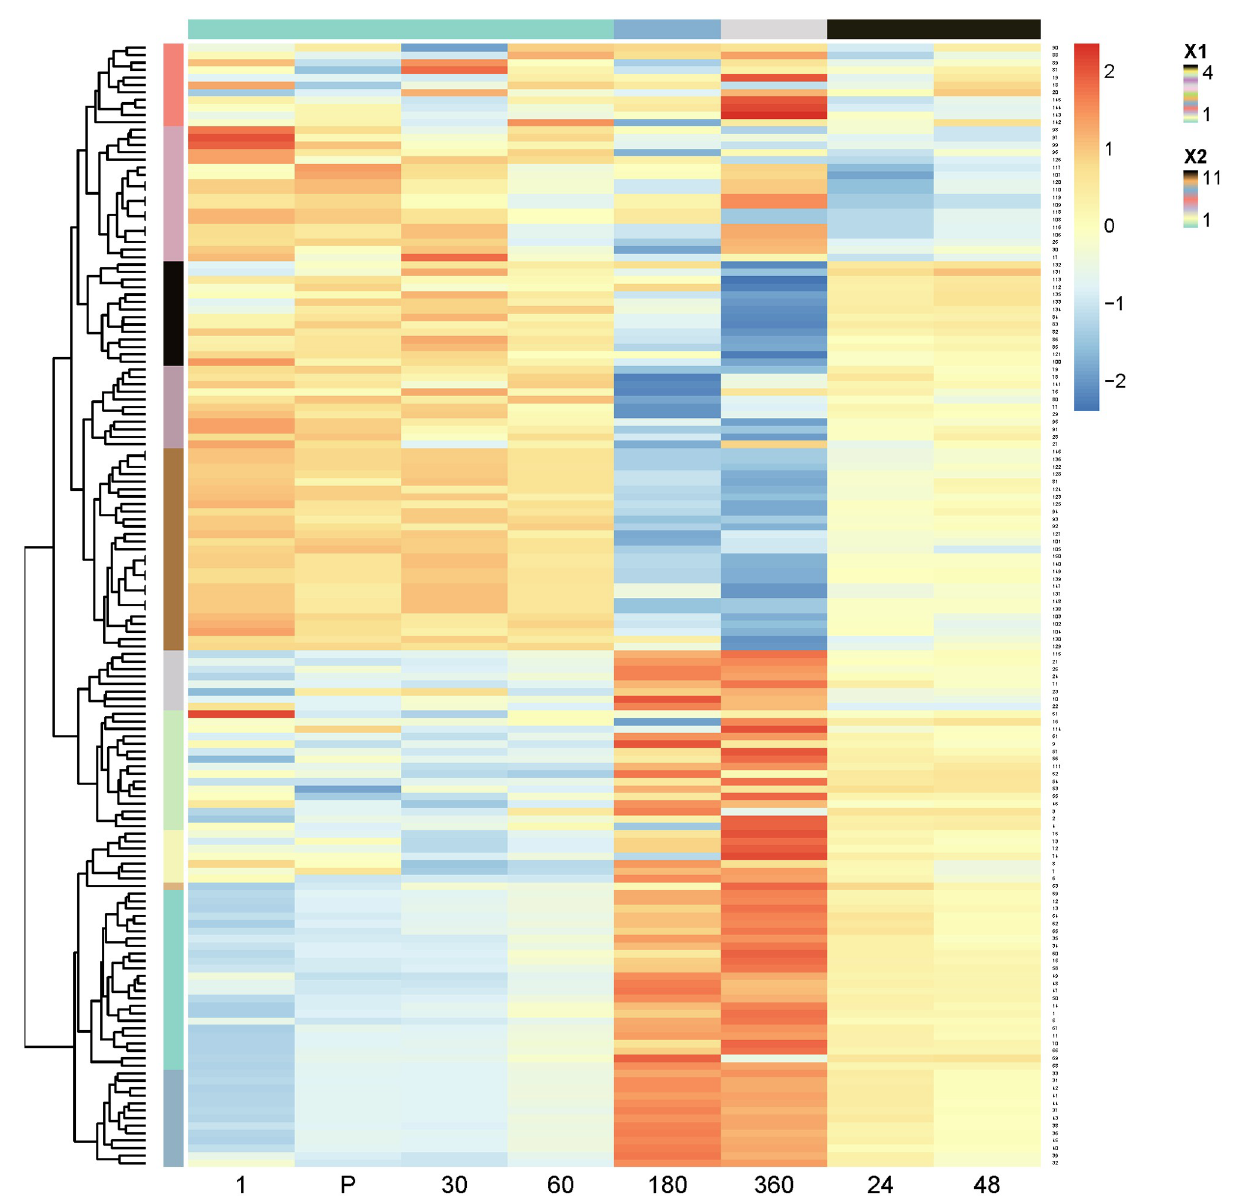
Fig 5. Scores for all 150 sample points ( y axis) and 8 time points ( x axis) for PC3. The colour of each cell represents the score value. Clusters of sample points are shown with coloured regions and a tree on the left hand side, and clusters of time points are shown on the top with coloured regions. 1, P, 30, 60 –corresponding to pre-, post-, 0.5 and 1 h after training are clustered together. 3 h and 6 h are in their own clusters, and 24 h and 48 h are clustered